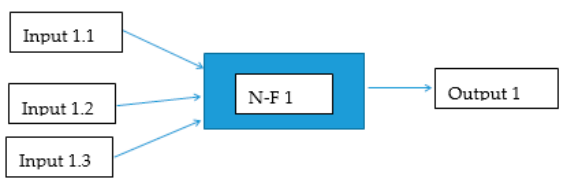
Figure 3. Model scheme without using sequential aggregation of inputs. Table 1. Parameters used for model